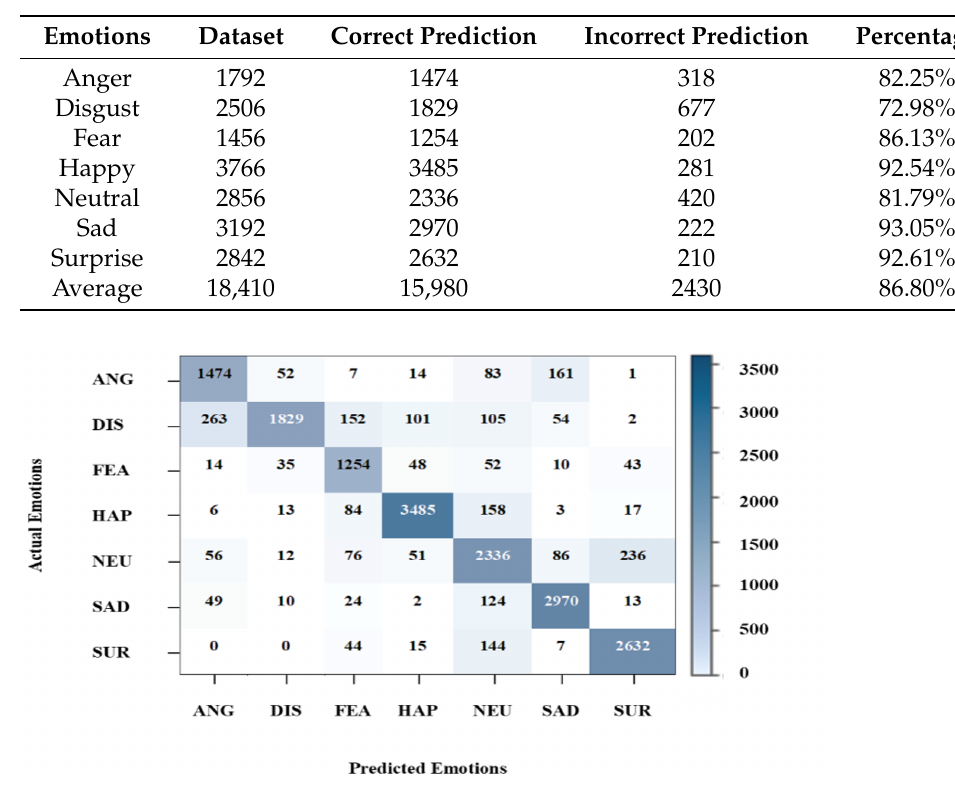
Figure 5. Confusion matrix of the proposed model after 10